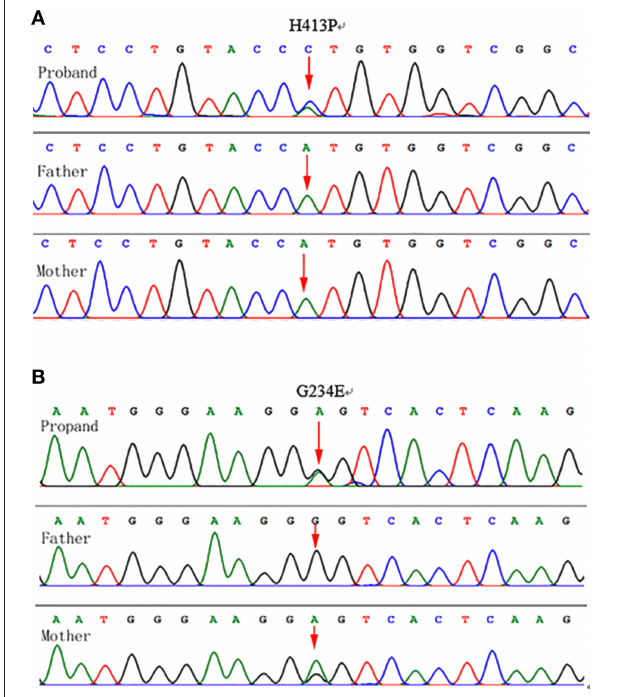
FIGURE 4 | Genotyping results: (A) Chromatograms showing DNA sequencing results for the proband and parents. Genomic DNA isolated from leukocytes (proband, mother, and father) demonstrated a novel heterozygous A-to-C transition at position 1,238 in exon 10 of the GBA gene was identified in the proband, which resulted in a His413Pro mutation. The mutation was not detected in the parental genomic DNA. (B) A heterozygous G-to-A transition at position 701 in exon 7 of the GBA gene in the mother and the proband, which resulted in a Gly234Glu mutation in the maternal and proband’s genomic